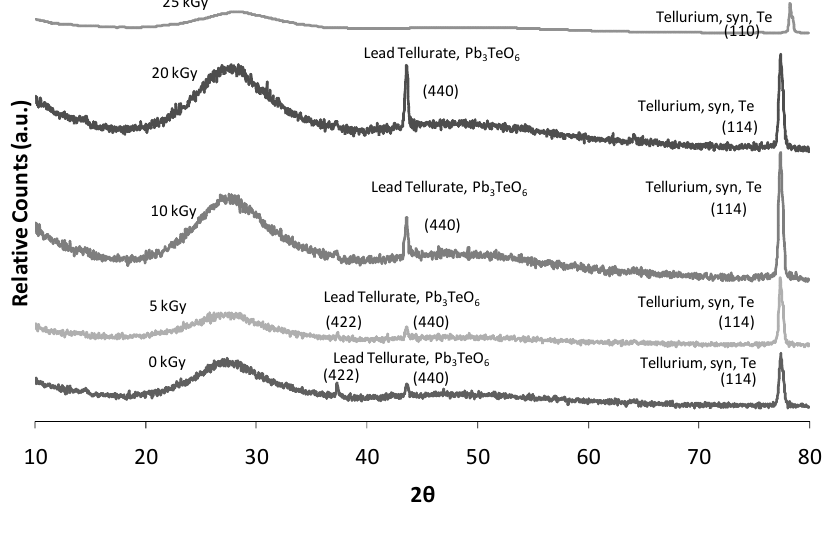
Figure 3. X-ray diffractogram patterns (at ambient temperature) of irradiation